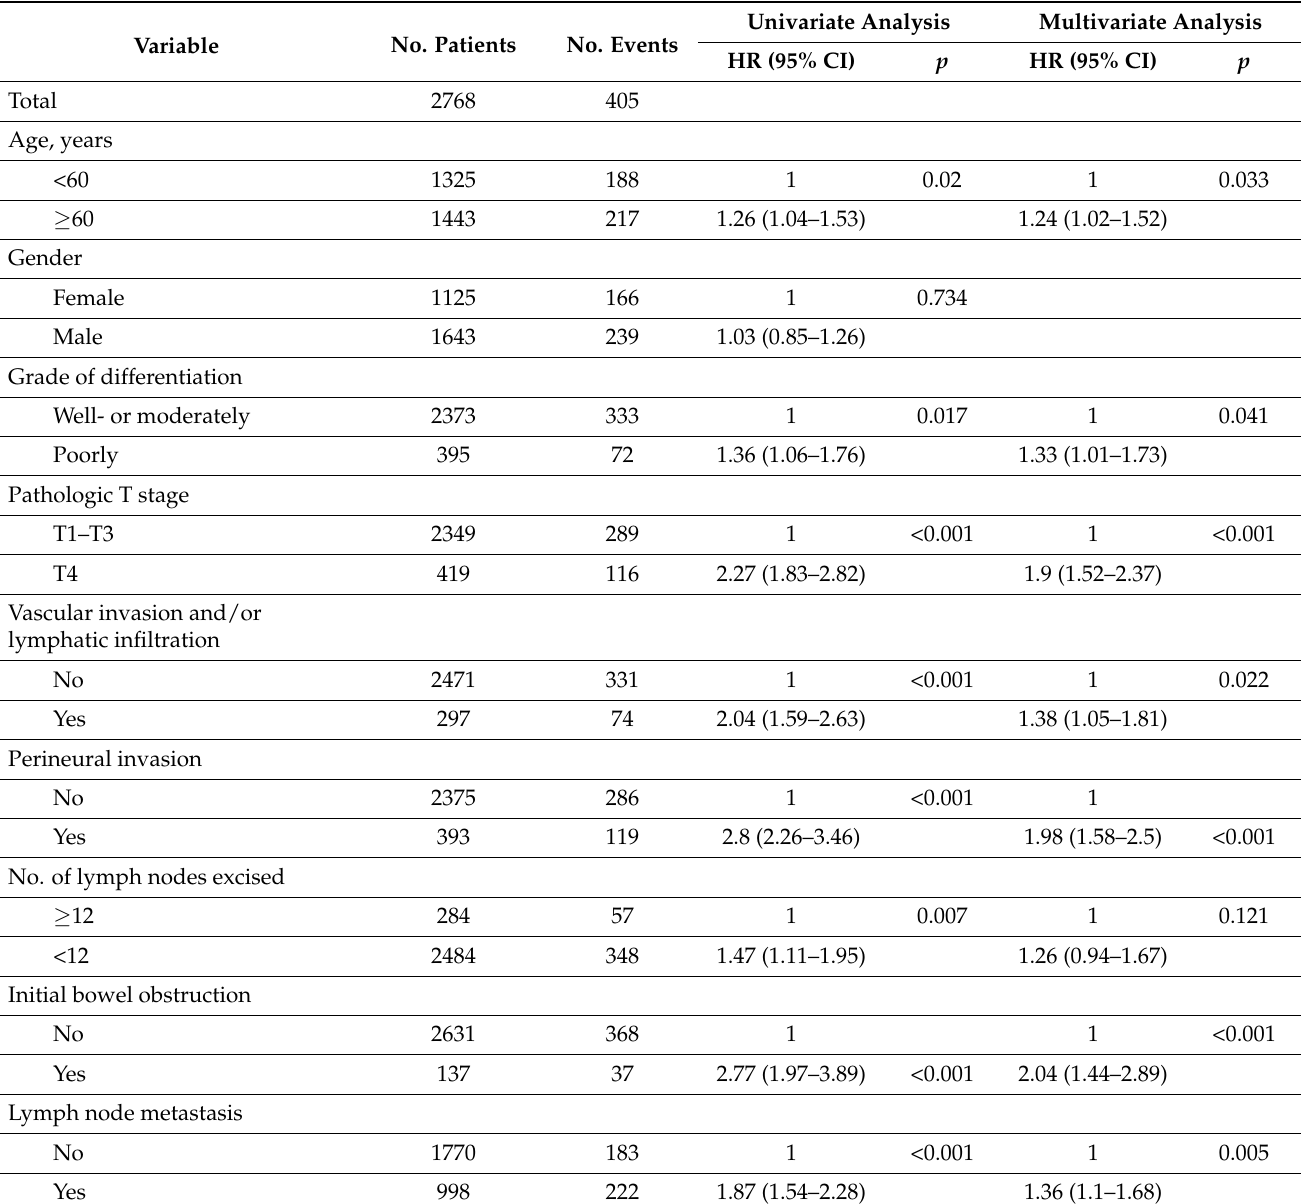
Table 2. Univariate and multivariate Cox proportional hazards regression model for disease-free survival of the overall